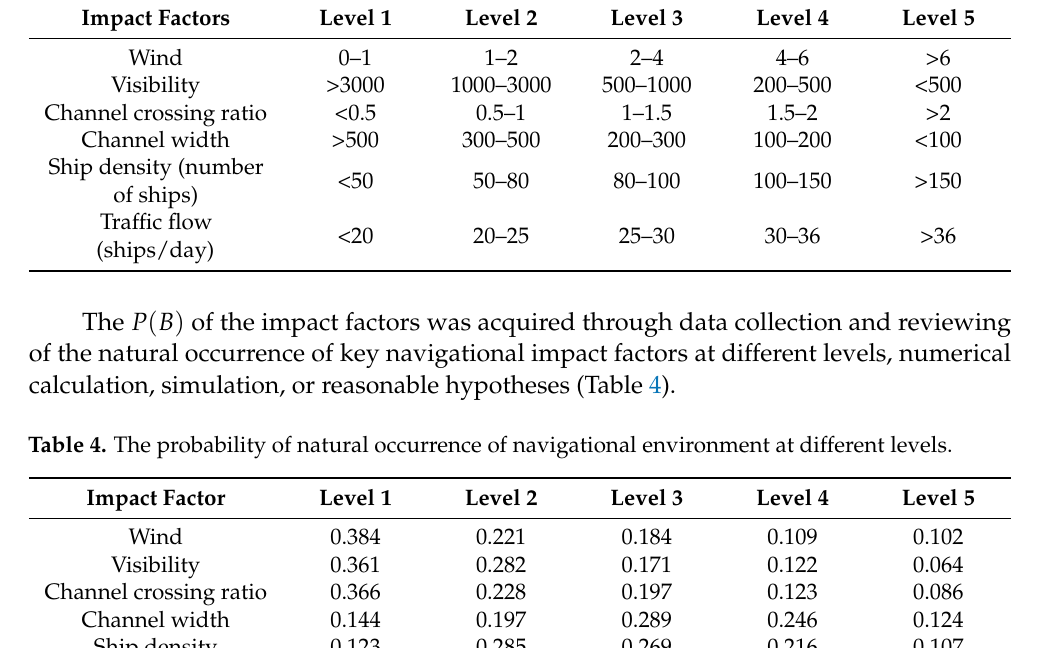
Table 3. Grading of the environmental impact factors of navigation.